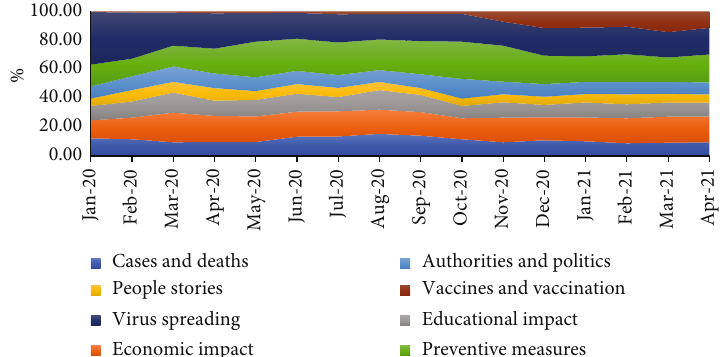
Figure 2: Figure illustrating the average distribution of the 8 topics across all channels, over time. Distribution was calculated as a percentage of all tweets per month. Table 4: Average news tweet emotion scores per topic.